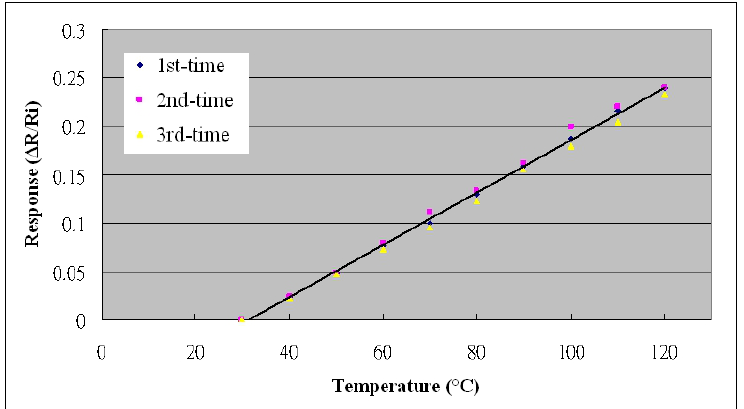
Figure 6. Calibration curve of micro temperature sensor.